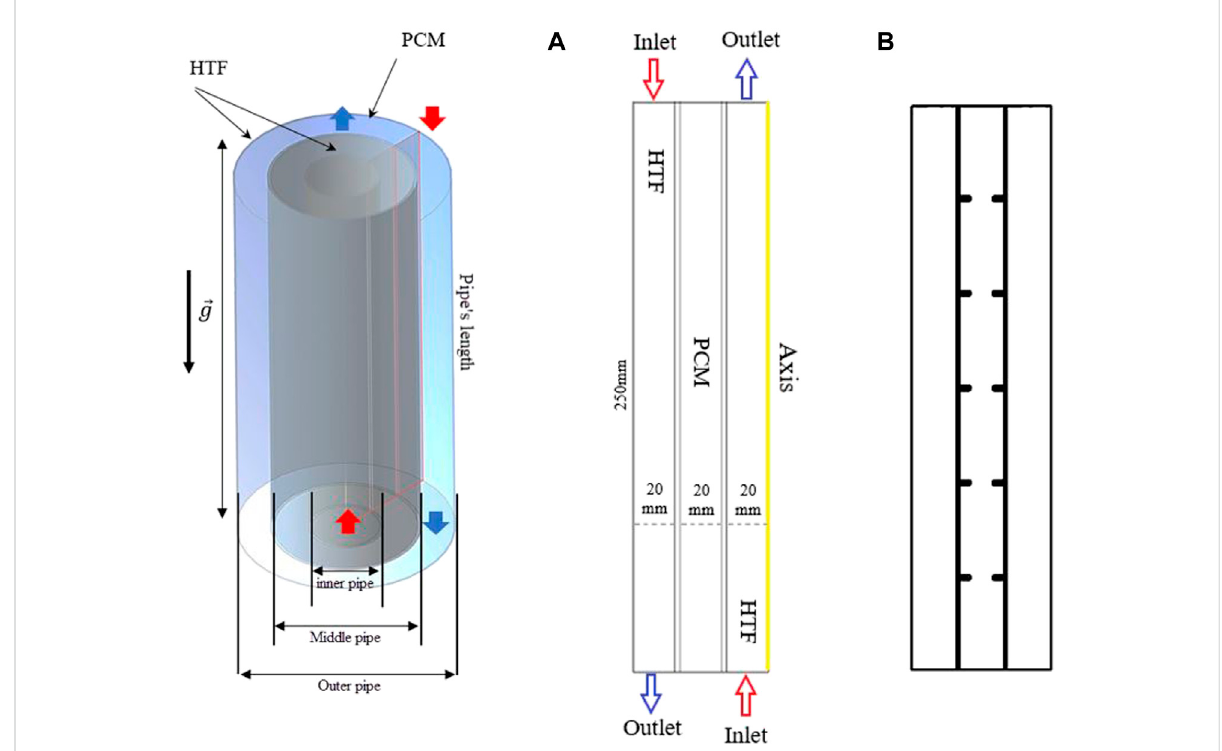
FIGURE 1 The schematic of a triplex tube heat exchanger with (A) no fi ns and (B) uniform fi